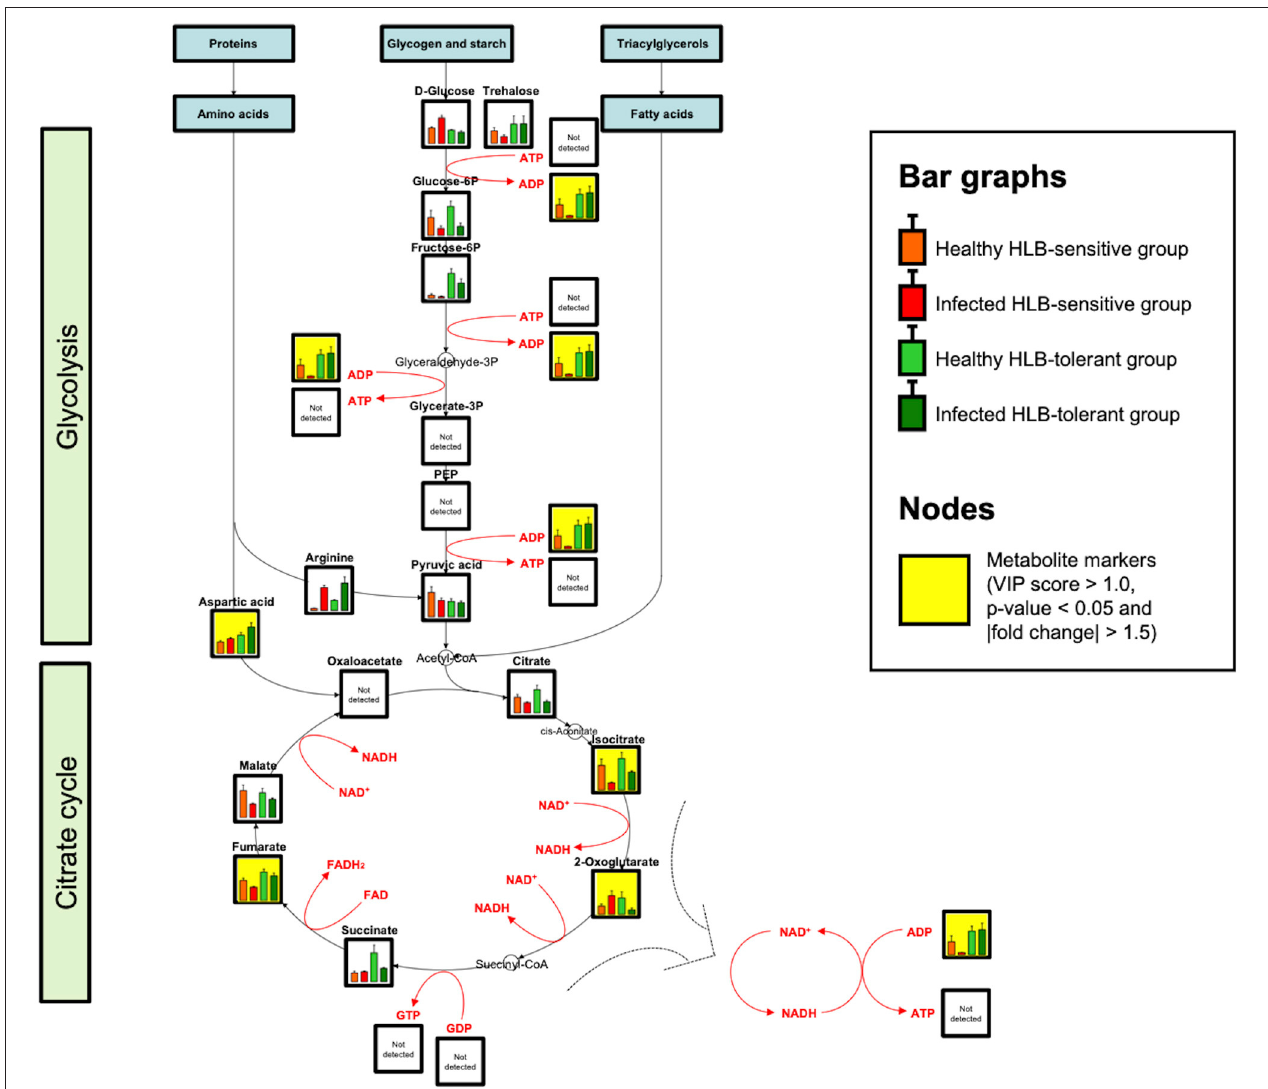
FIGURE 4 | Catabolic pathways and metabolite mapping ( n = 9). Central catabolic pathways including glycolysis and citrate cycle are investigated and visualized. Bar graphs show metabolite levels with SE in healthy HLB-sensitive group (orange), infected HLB-sensitive group (red), healthy HLB-tolerant group (light green), and infected HLB-tolerant group (green) based on the integrated results. Yellow background indicates marker compounds (VIP score > 1.0, p -value < 0.05, and |fold change| > 1.5) in the